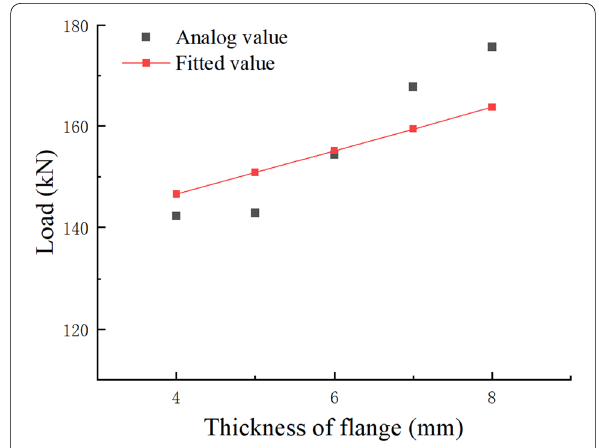
Fig. 21 Effect of flange thickness on the strength of the